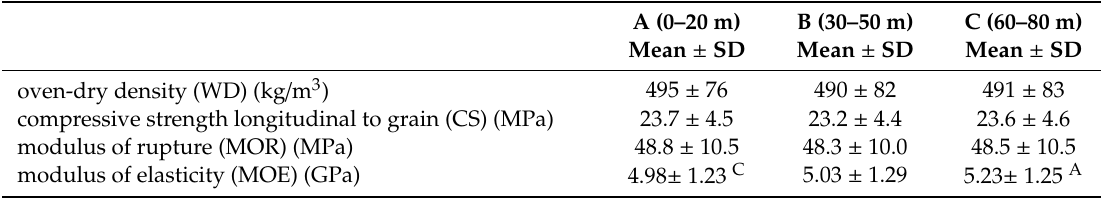
Table 4. Wood properties